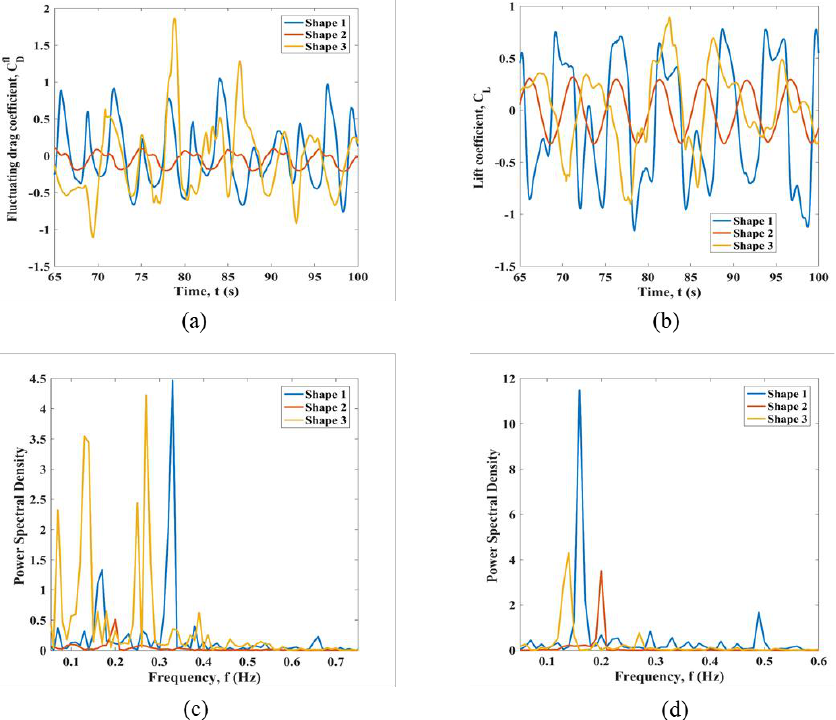
Figure A12. Fluid force coefficients for cylinder 3 immersed in uniform flow: ( a ) time history of the fluctuating drag coefficient; ( b ) time history of the lift coefficient; ( c ) the fluctuating drag coefficient FFT; ( d ) the lift coefficient FFT.